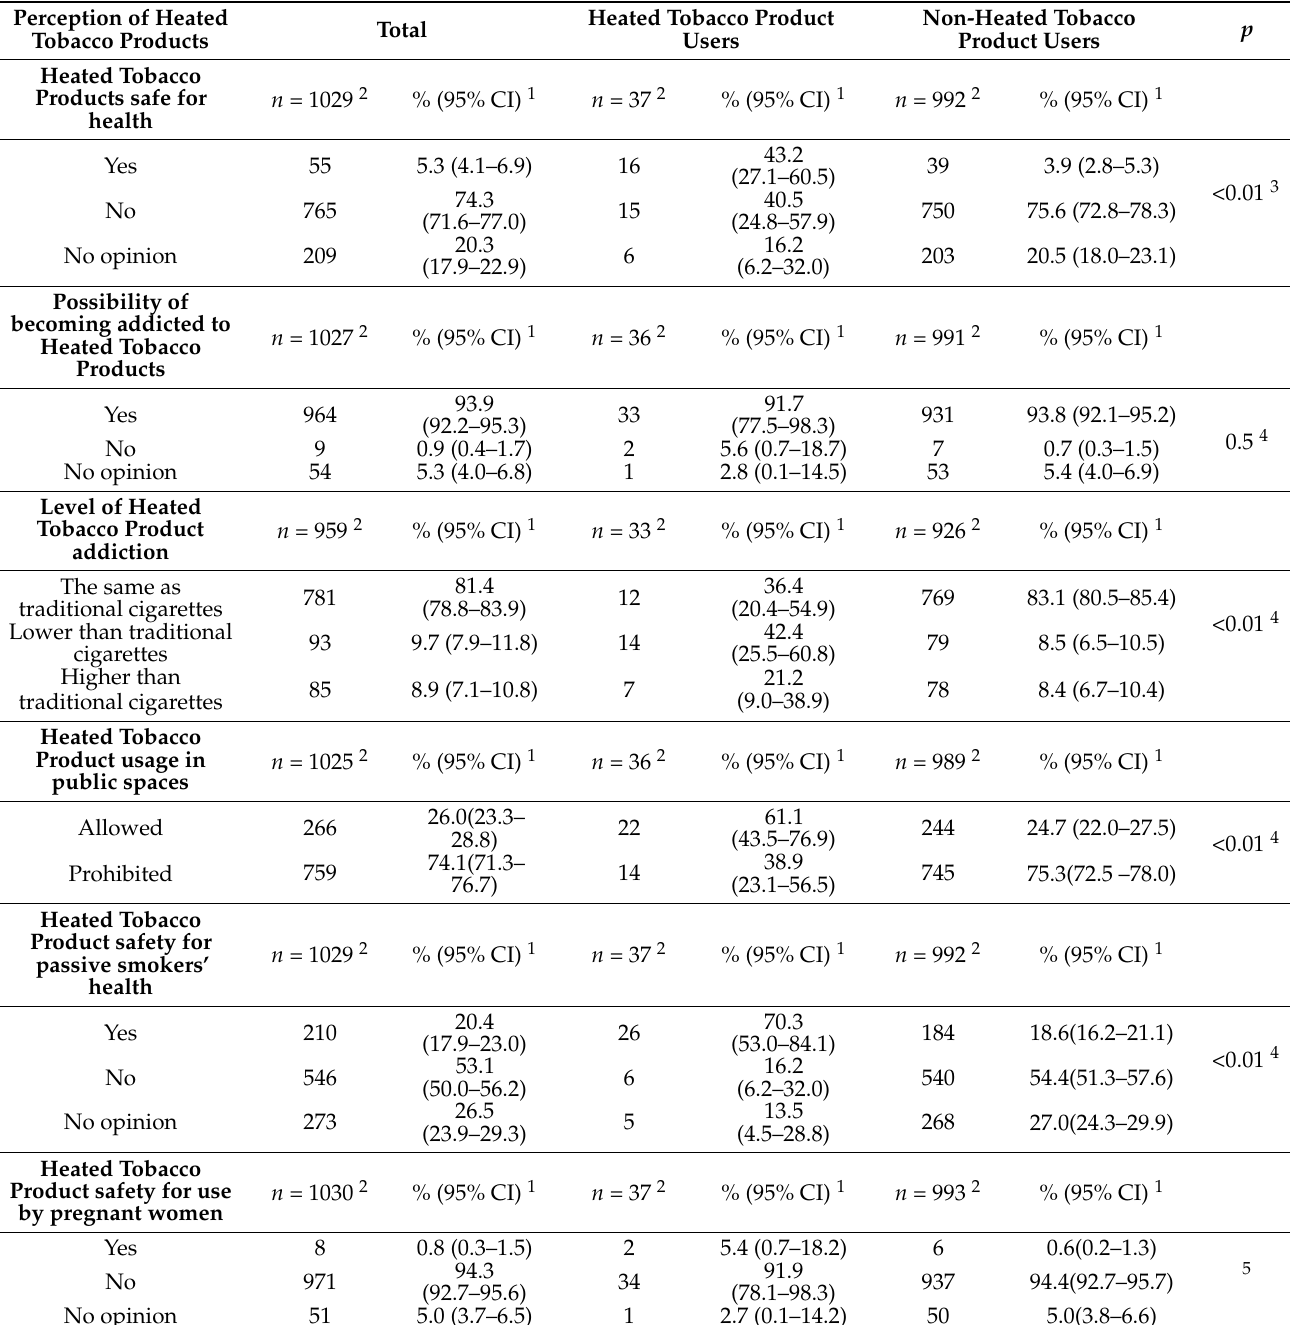
Table 3. Opinions about HTP safety, safety for passive smokers and pregnant women, addiction to HTPs and usage in public spaces among medical